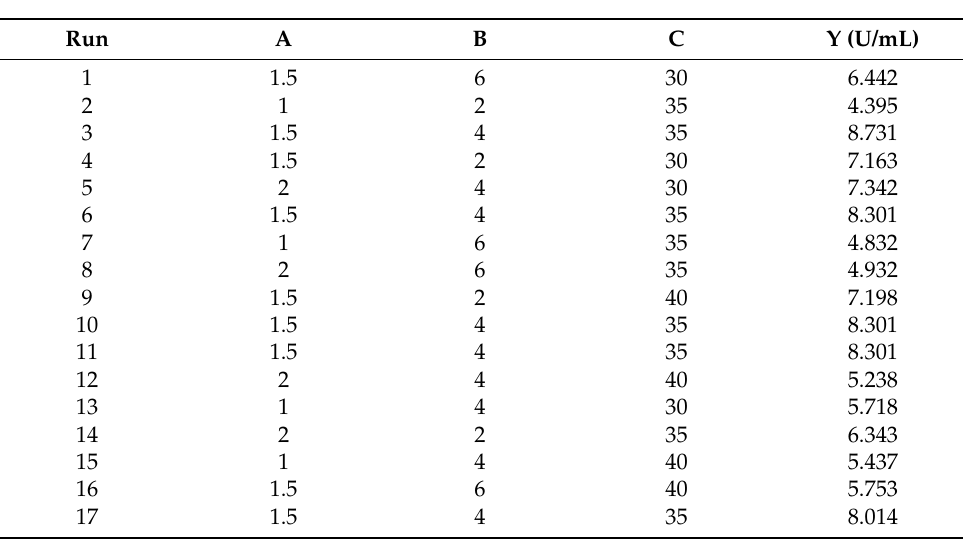
Table 6. Experiment design and result of response surface